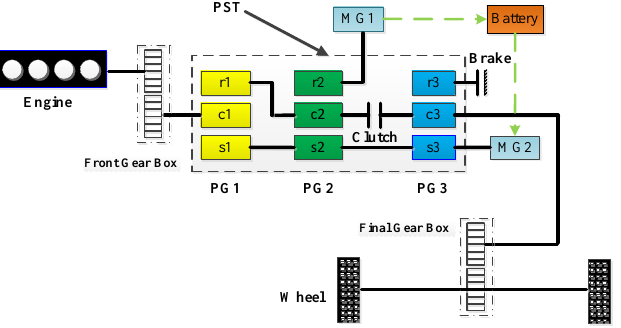
Figure 2. Configuration of hybrid heavy-duty vehicle (HDV) with power-split transmission (PST).